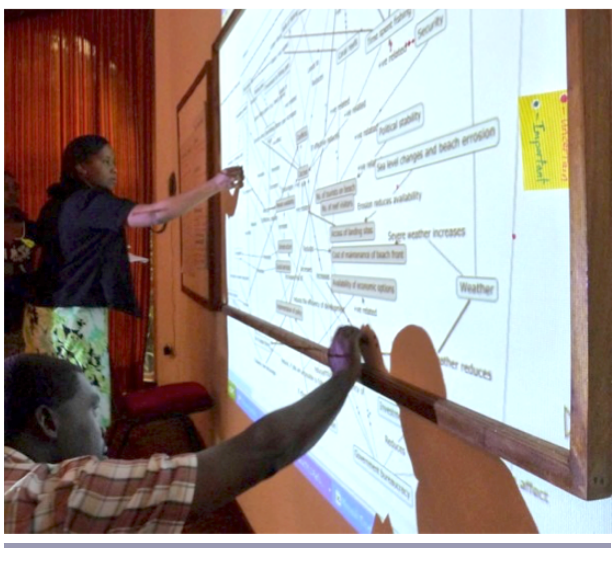
Fig. 2 . Participants working on a system diagram during workshop 1.